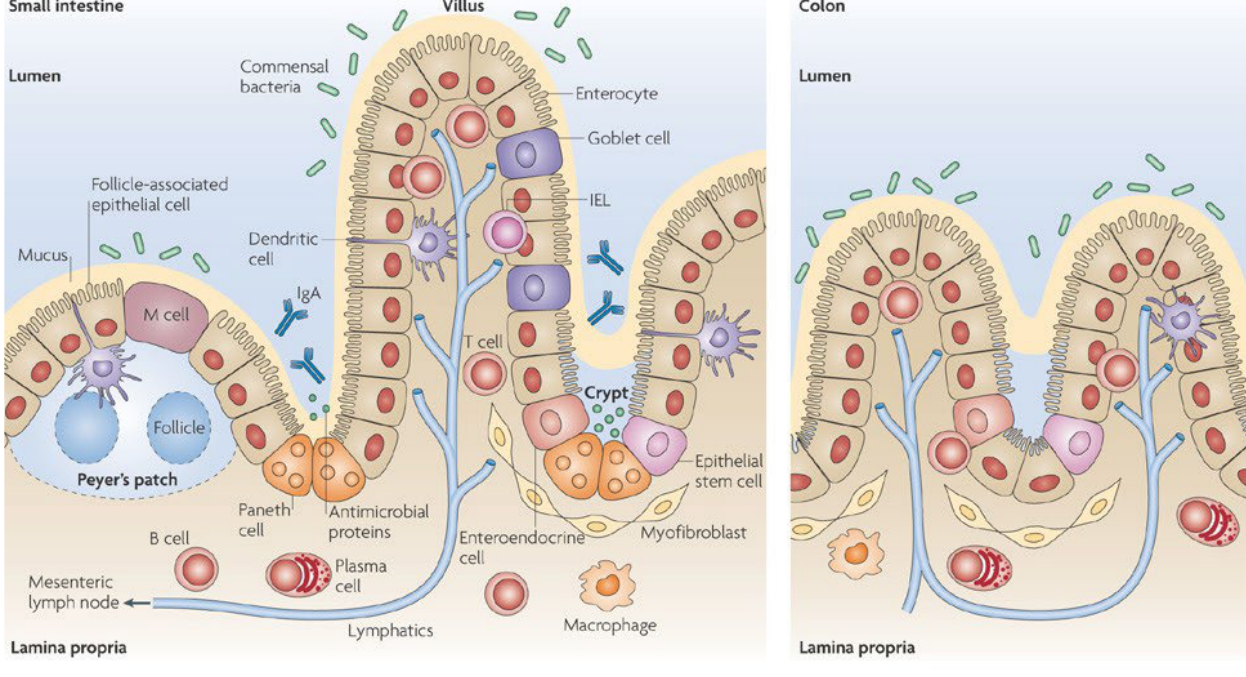
Figure 1. Schematic representation of intestinal epithelium cells and their localization [4].